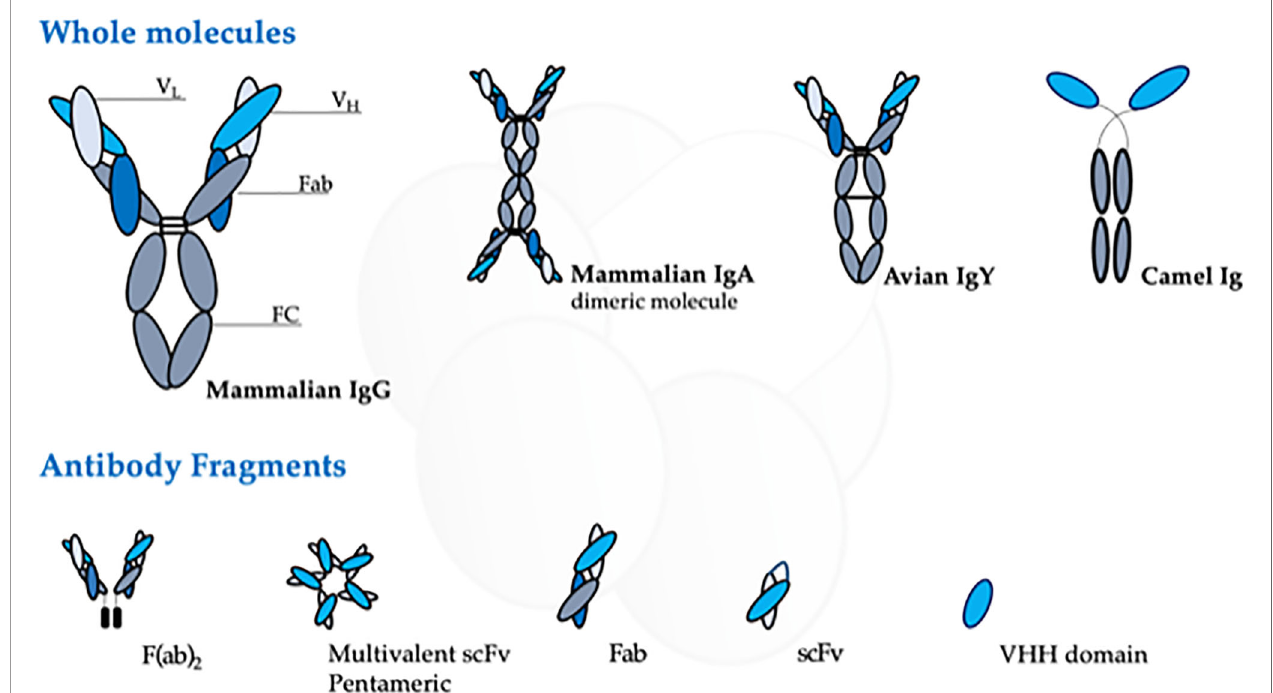
FIGURE 2 | Schematic representation of the different antibody source, structure, and arrangement presented at this review. The fi gure highlights the domains of the mammalian IgG, the most used antibody